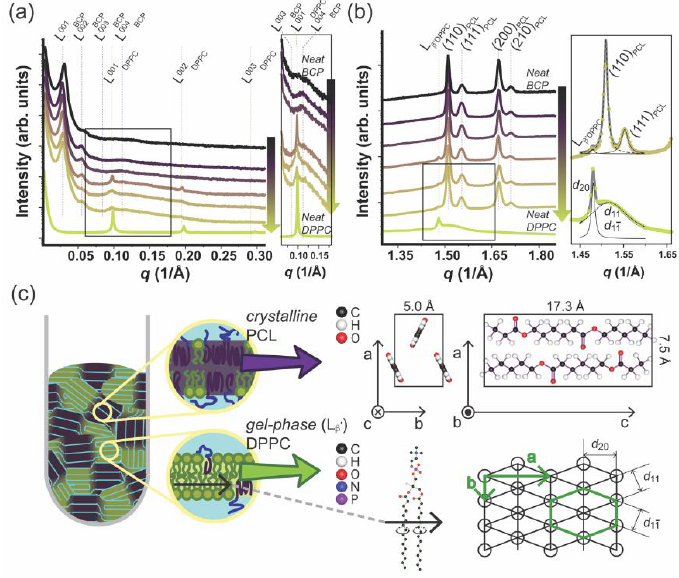
Figure 5. Simultaneous ( a ) Small Angle X-ray Scattering and ( b ) Wide Angle X-ray Scattering profiles obtained for hydrated neat mPEG- b -PCL(denoted as BCP above), neat DPPC, and their mixture. (From top to bottom; 0, 20, 40, 50, 60, 80, 100 mol% DPPC. Inset is a zoom-in image.) The function used for curve fitting is a Lorentz function (inset, ( b )) ( c ) Graphical illustration of nanostructured hybrid material of mPEG- b -PCL and DPPC (left) and crystallographic information of each component